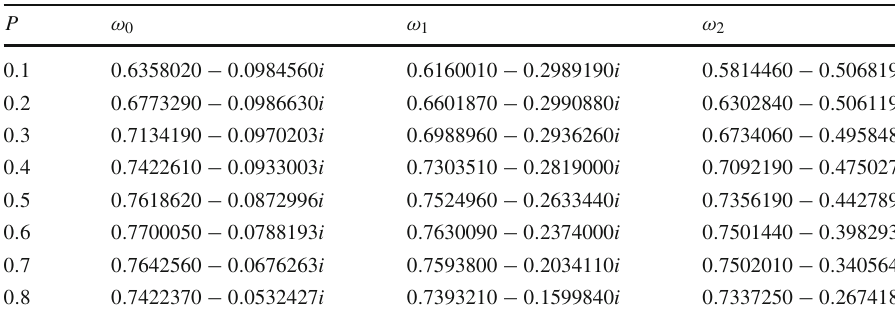
Table 2 The first LQBH’s quasinormal modes for l = 3